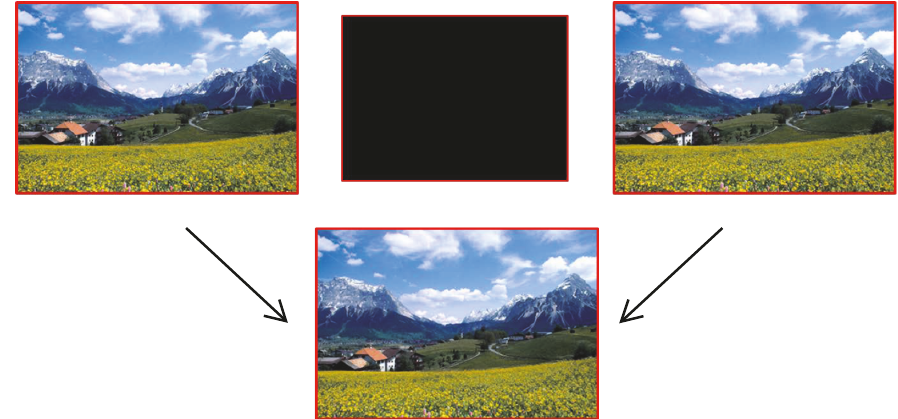
Figure 8: A schematic view of how, if we close our eyes for a moment and open them again, we normally merge the before and after views to make one. The landscape here and in Figure 9 is from Wallpapers Buzz (https://www.wallpapersbuzz.com), reproduced with